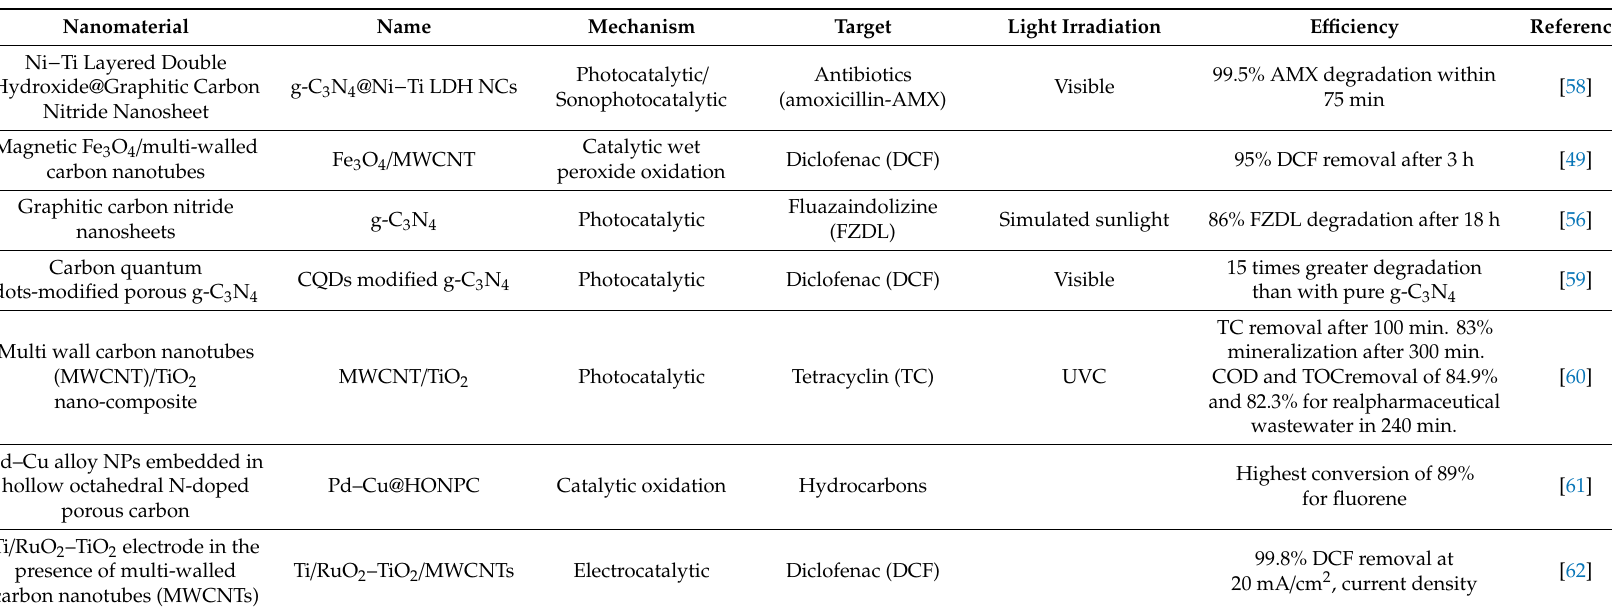
Table 1. Selected publications on the development and application of carbon nanotubes, graphitic carbon nitride (CNT / g-C 3 N 4 ) nanomaterials for advanced water